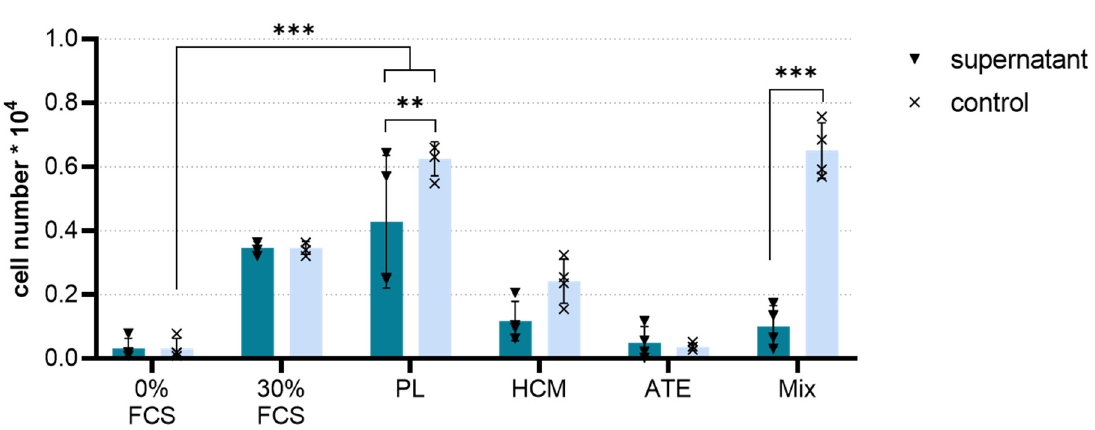
Figure 3. Transwell migration assay. The number of hBM-MSC migrated within 24 h towards supernatants containing released factors from the functionalized scaffolds (dark blue bars) or towards control solutions containing the same amount of bioactive factors that were added to the scaffolds (representing a 100% release; light blue bars) as determined by lactate dehydrogenase (LDH) activity measurement (mean ± SD, n = 4 as represented by black triangles and crosses within bars, 2-way ANOVA following Tukey’s post hoc tests: ** p < 0.01, *** p < 0.001; 0% FCS: negative migration control, 30% FCS: positive migration control).